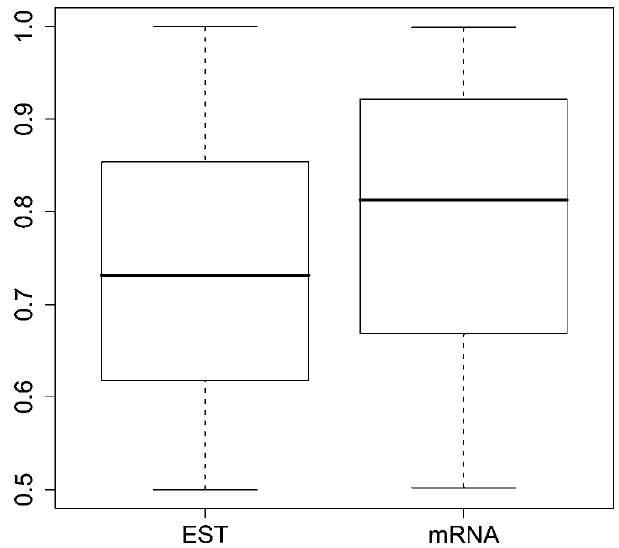
Figure 4. Boxplots of fusion location. Distribution of fusion location for 5614 EST and 587 mRNA chimeras. The fusion location is represented as a fraction X of sequence length. Fractions Y , 0.5 have been transformed to X =1 2 Y .